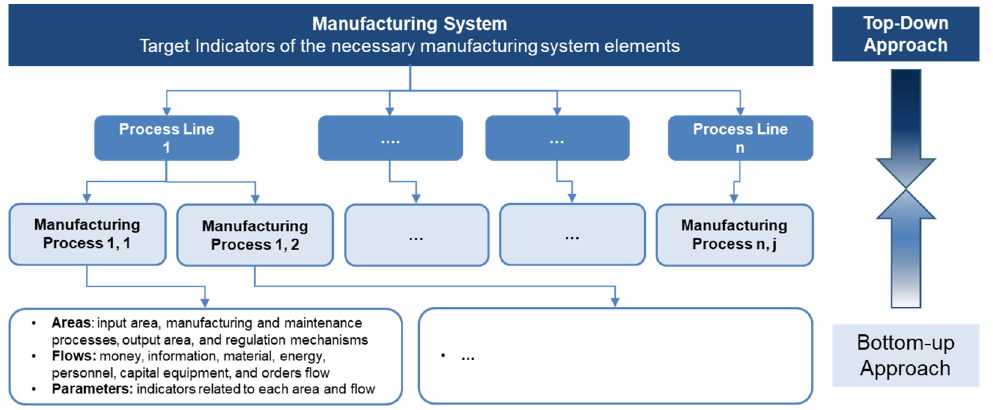
Figure 3. Manufacturing system assessment (own elaboration).